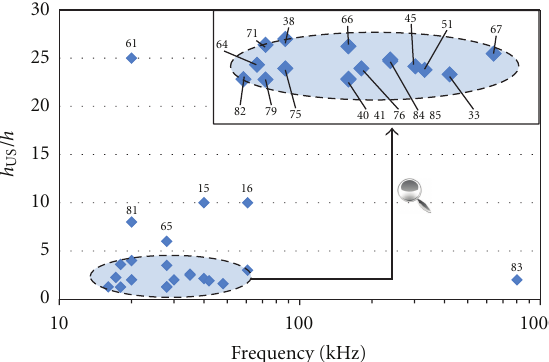
Figure 9: Influence of frequency on the increase of convection heat transfer coe ffi cient.